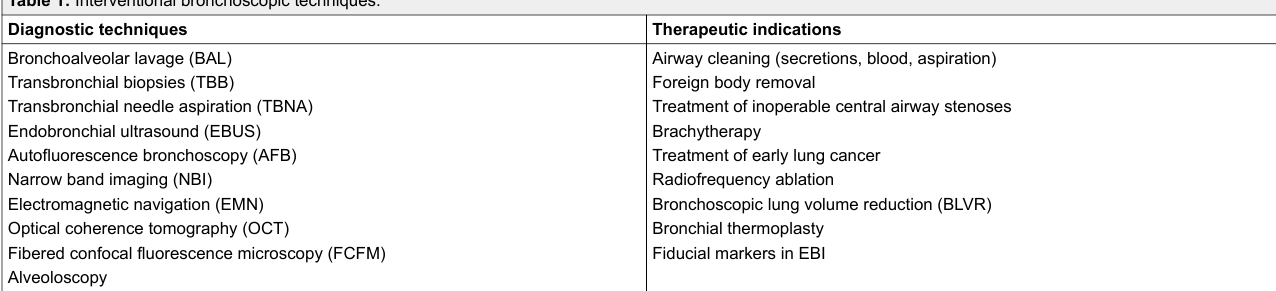
Table 1: Interventional bronchoscopic techniques. Diagnostic